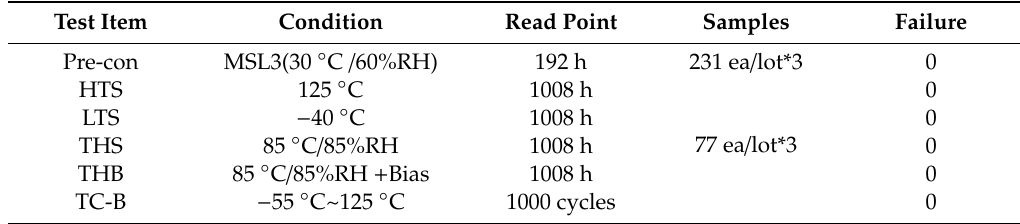
Table 11. Reliability test items and